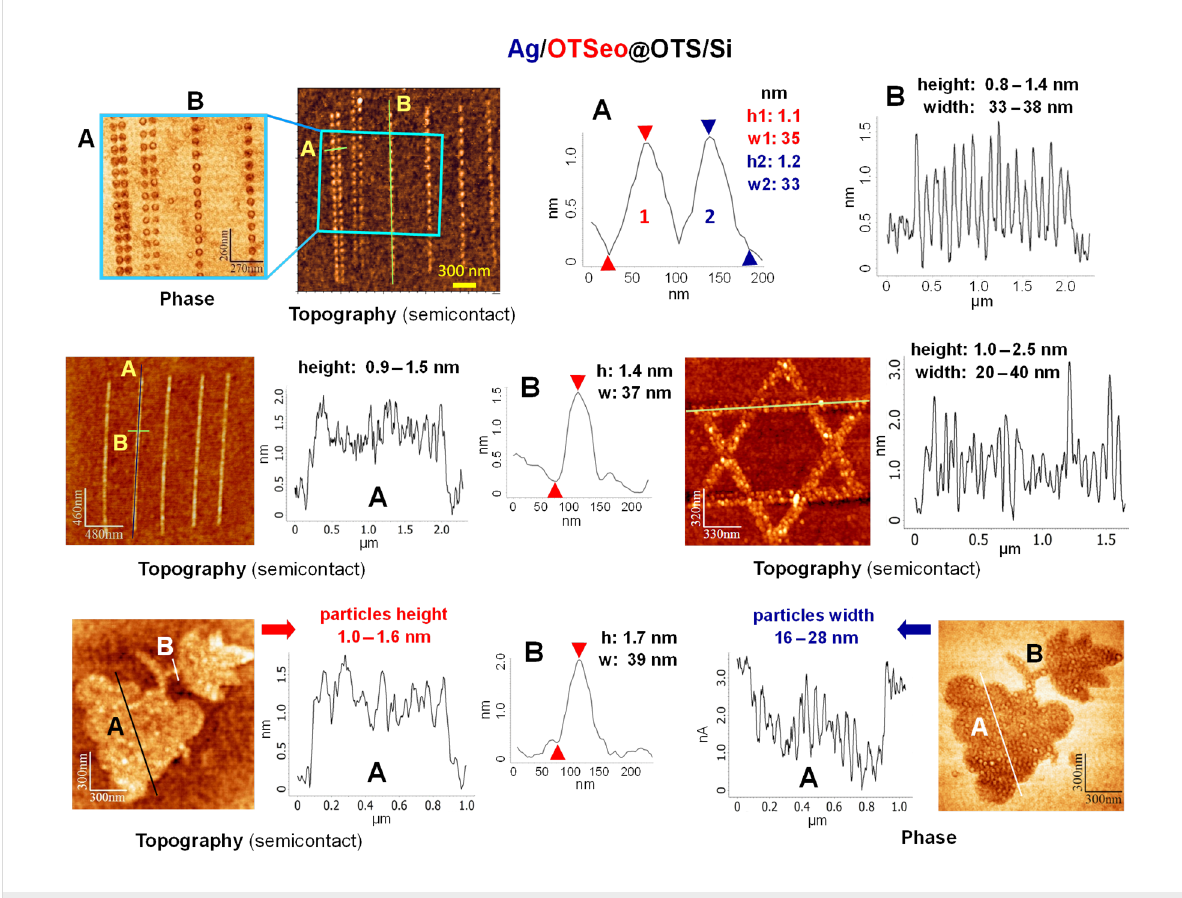
Figure 3: Semicontact SFM images (and distance–height profiles along the marked lines) of different silver/monolayer nanostructures fabricated in the same manner as the nanodots in Figure 2 (see text and Experimental section).